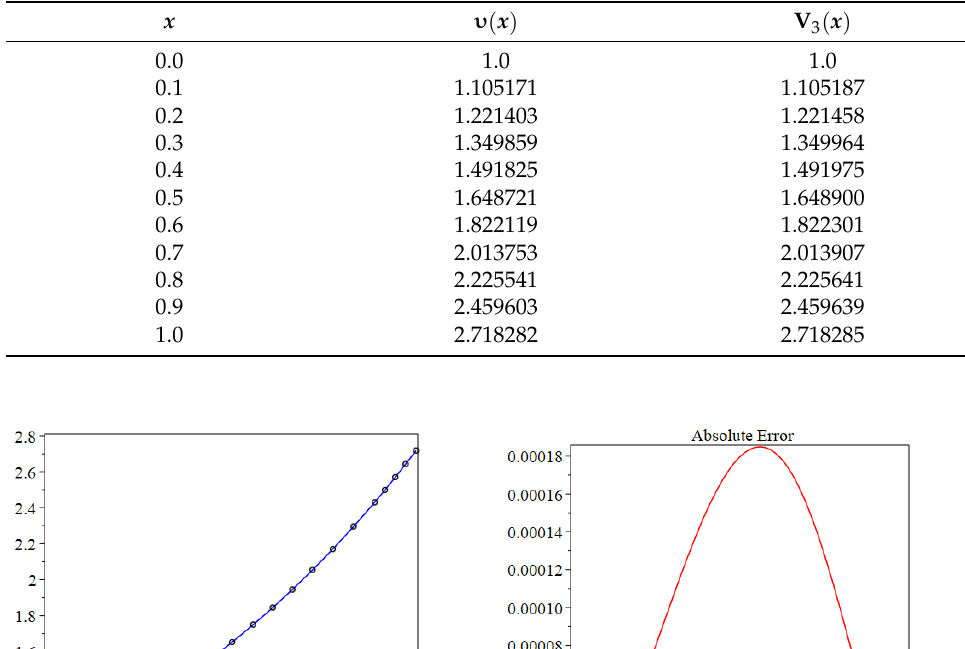
Table 3. A comparison between the numerical results of υ ( x ) and V 3 ( x ) .